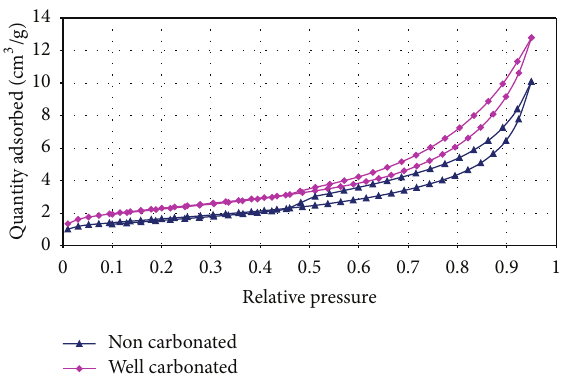
Figure 1: Nitrogen adsorption desorption on the powder sample.